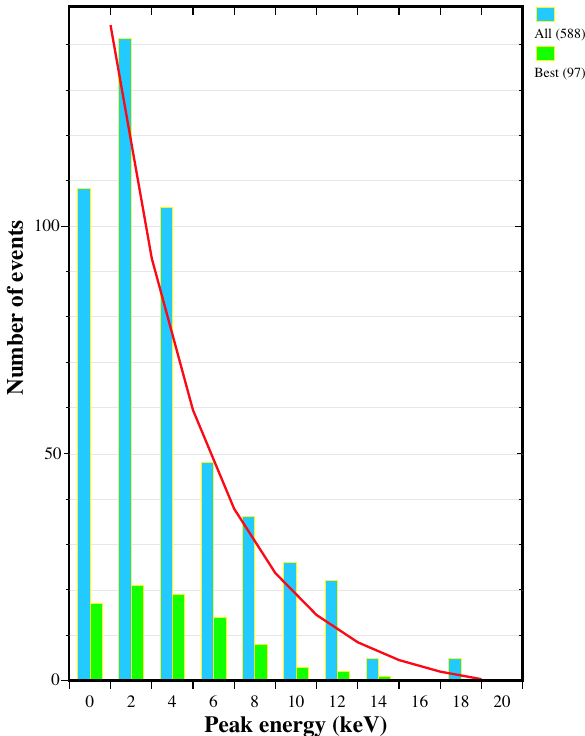
Fig. 3. Seasonal distribution of inverted-V events. Most events are captured during the winter months, but another smaller population shows up during summer. The curve shows the seasonal variation of the electron flux ratio of Northern and Southern Hemispheres (Barth et al., 2004). Inverted-V events of this study have mainly been recorded over the norther auroral region.